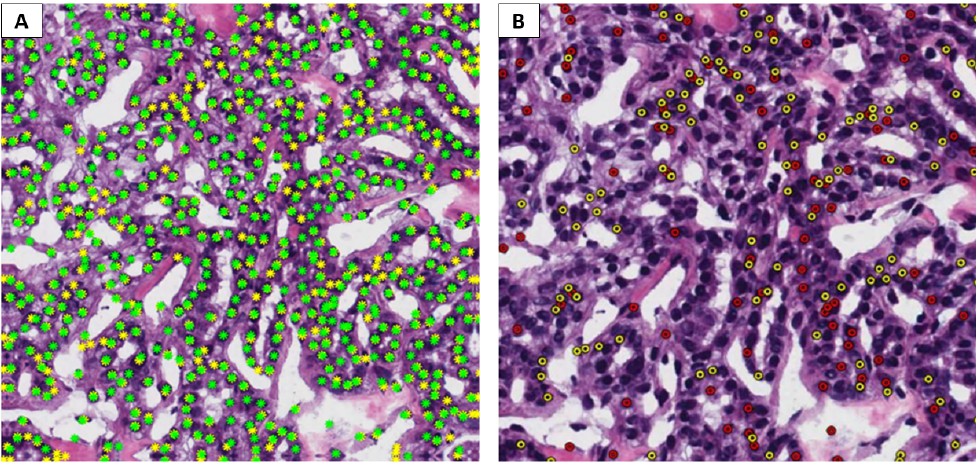
Figure 5. Example of calculation of evaluation metrics for object detection. ( A ) Prediction vs ground truth. Yellow, ground truth; green, prediction; ( B ) Differences between prediction and ground truth. Yellow, detection FN; red, detection